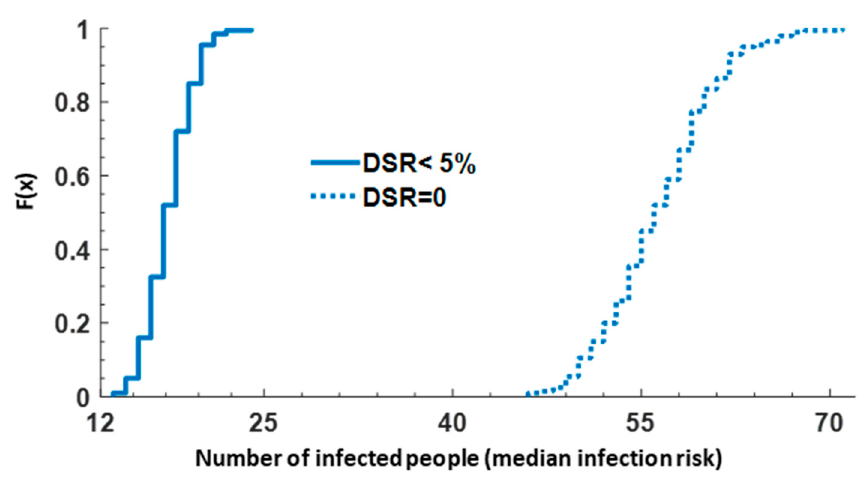
Figure 10. Probability distributions of the number of infected people during the first day of simulation when people with a DSR null and less than 5% do not drink water from tap; 200 Monte Carlo simulations for each scenario; C out = 560 oocysts/L with 1 h of PDCs with daily consumption patterns.